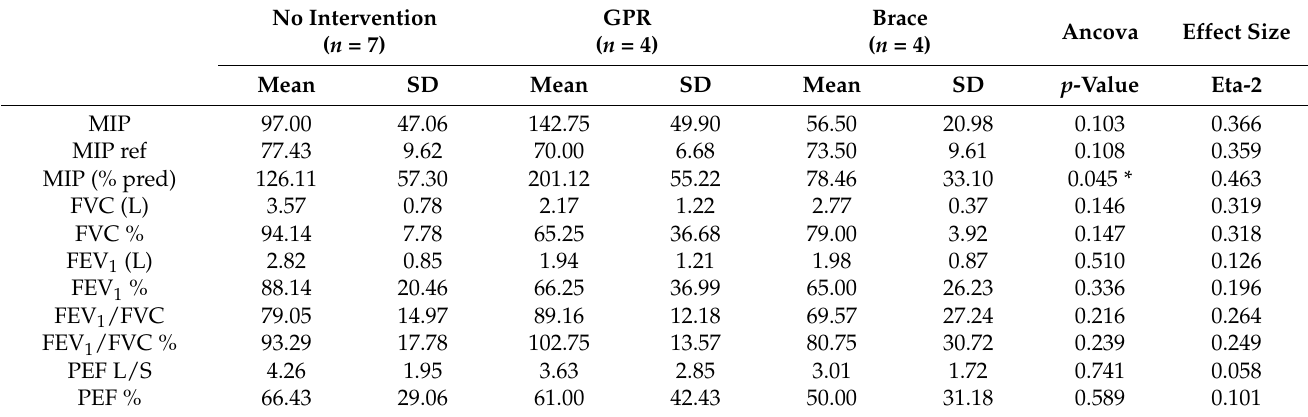
Figure 4. Strength scores for the different groups (GPR: Global Postural Reeducation; MIP: maximum inspiratory pressure measured in cmH 2 O). Table 3. Mean difference in treatment